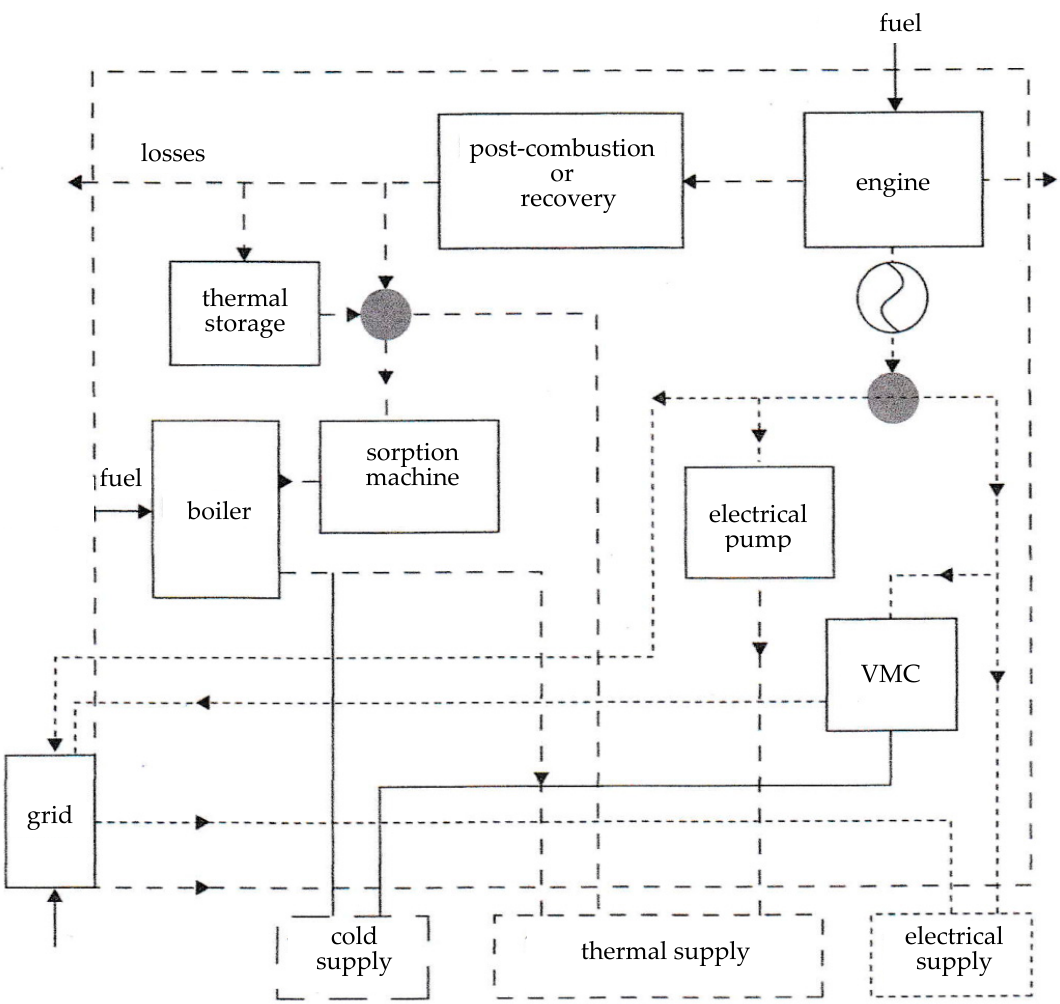
Figure 11. Trigeneration configuration with gas engine and vapor mechanical compression machine (VMC).